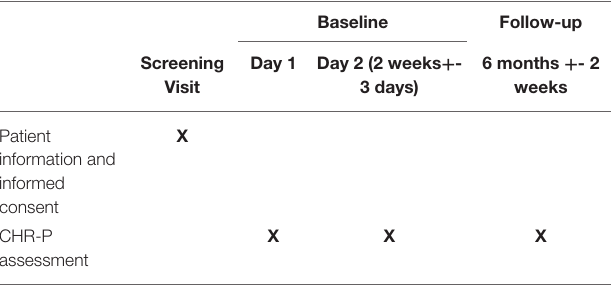
TABLE 2 | Study procedures for individuals detected by the transdiagnostic risk calculator and referred by clinicians for an assessment for